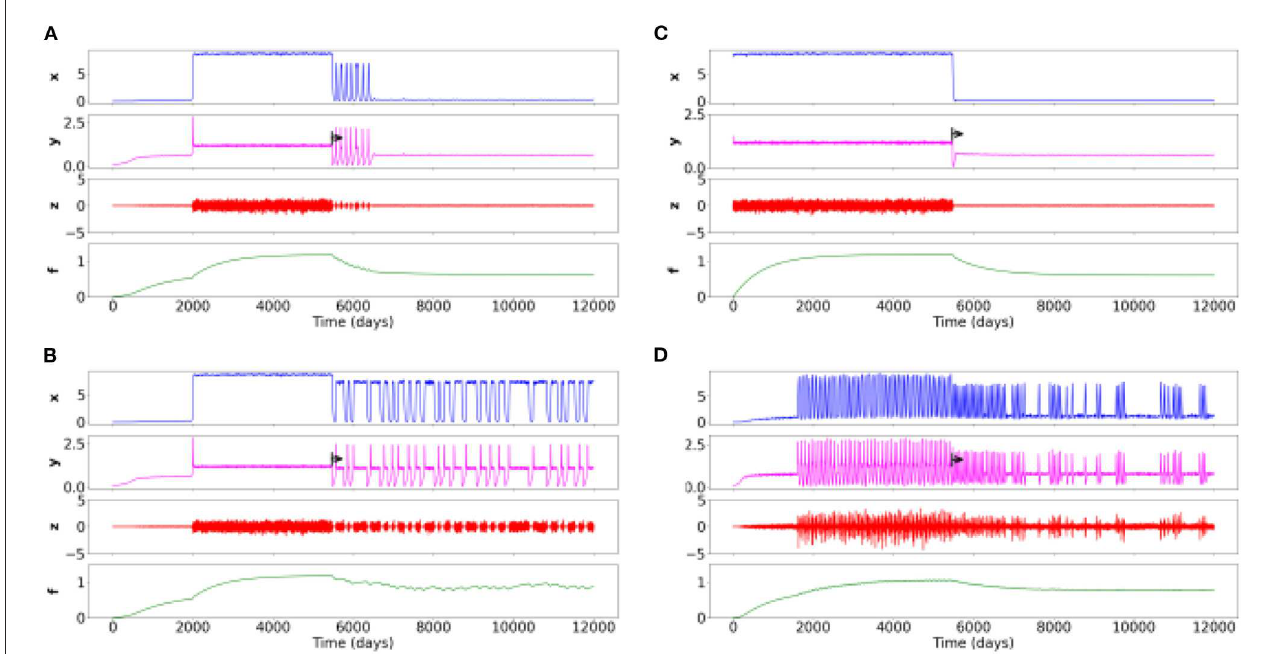
FIGURE3 Time series of four simulations for different sets of parameters with a therapeutic action on different psychiatric disorders. The black arrow corresponds to the beginning of the treatment. (A) Schizophrenia spectrum with effective treatment. (B) Schizophrenia spectrum with insufficient treatment. (C) Childhood-onset disorder (e.g., neurodevelopmental disorder) treated with a fast-acting drug (e.g., methylphenidate) or another therapy. (D) Rapid cycling bipolar disorder with an ineffective treatment but with an action on the frequency, regularity and intensity of cycles.